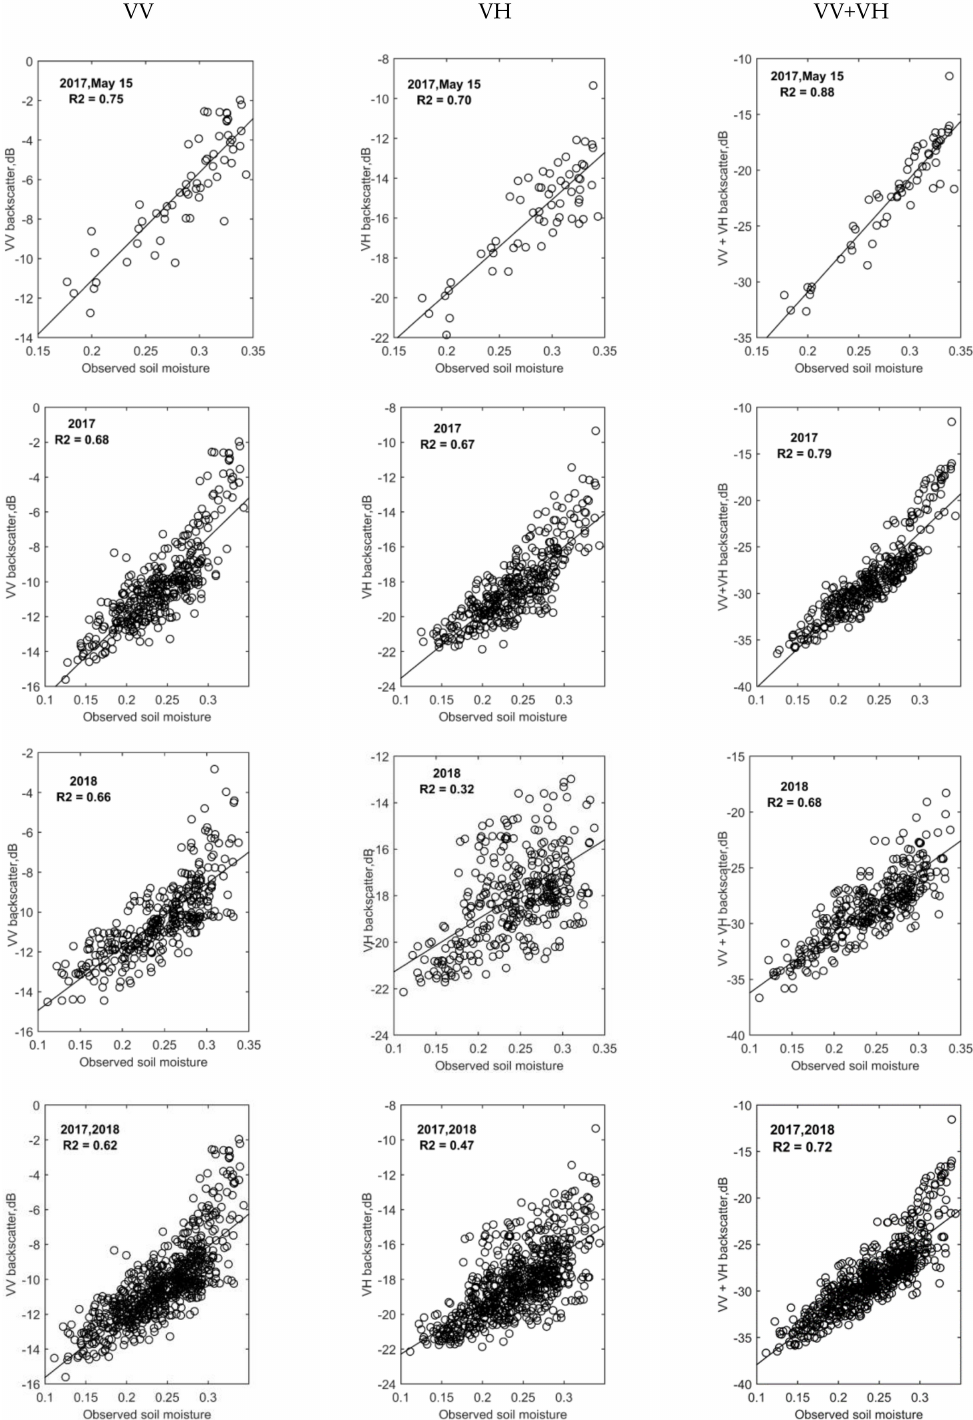
Figure 5. Localized and generalized linear models between soil moisture and backscatter. ( Top ) Examples of localized models refer to the Sentinel-1 acquisition of 15 May 2017. The remaining rows refer to the generalized models obtained using all Sentinel-1 images acquired in 2017, 2018, and in the total study from 2017 to 2018. The images from left to right represent Sentinel-1 images VV, VH, and VV + VH backscattering coe ffi